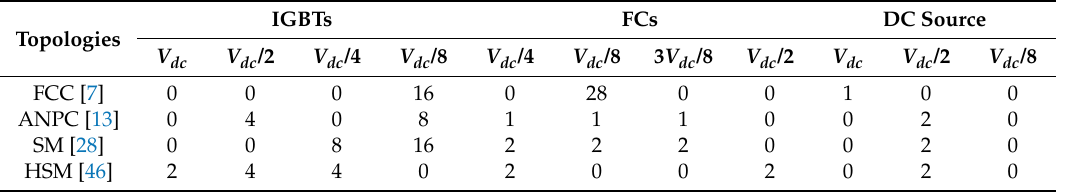
Table 3. Comparison of voltage ratings for 9-level FC-based multilevel